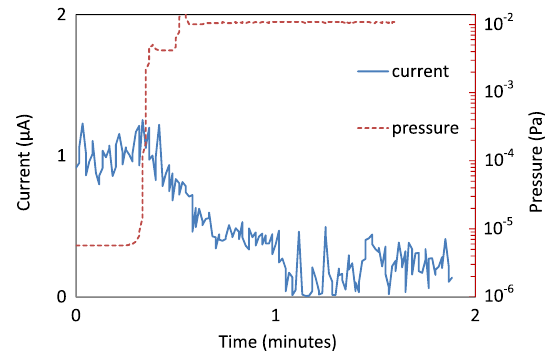
FIG. 6. Field emission current with nitrogen injection: 2 cm gap distance, 16 kV applied voltage.